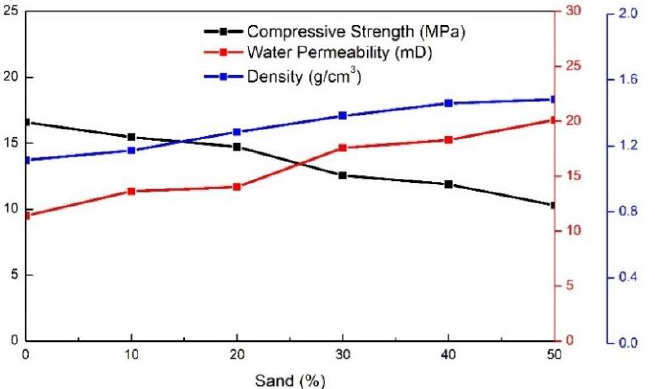
Figure 8. Effect of different mass concentrations on the performance of permeable cement stone.